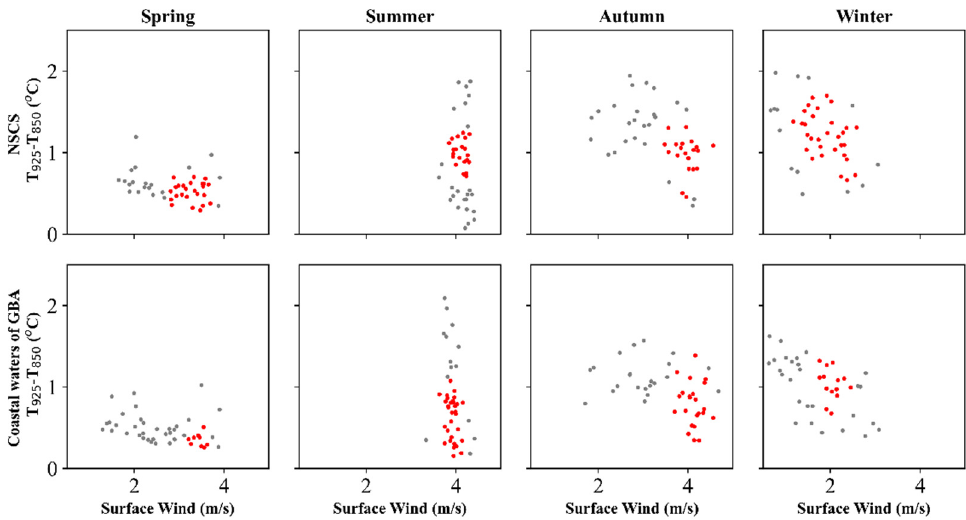
Figure 9. Seasonal condition of the monthly average 10-m wind speed (Wind_10) and temperature difference between 925 hPa and 850 hPa ( Δ T) from 2006 to 2020 over the NSCS and the coastal waters of the GBA. Red dots indicate the high-density dots according to the DBSCAN method.